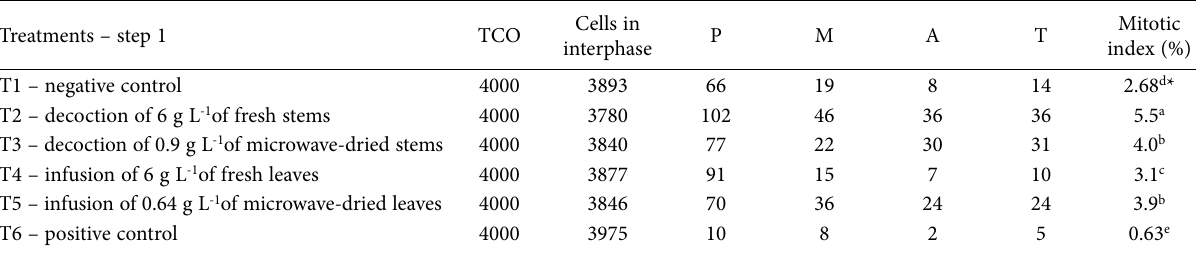
Table 1. Number of analyzed Allium cepa cells and mitotic indices (MI) of treatments with fresh and dried leaves and stems of Plectranthus barbatus